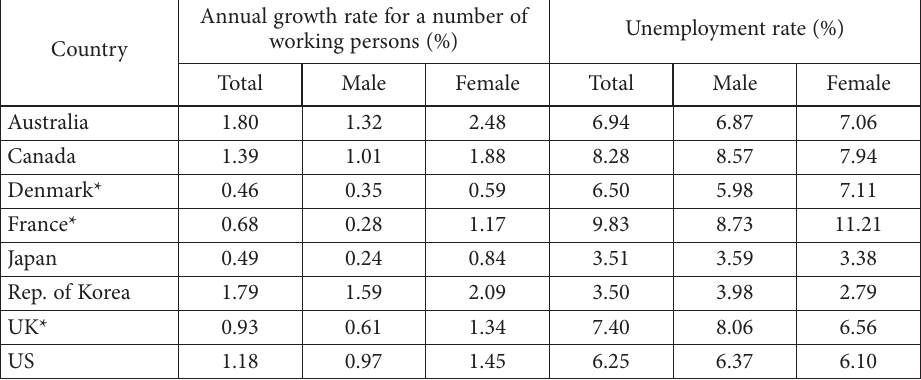
Table 1. Basic statistics of a number of working persons and the unemployment rate in selected coun- tries in the years 1981–2018 (source: own calculations based on the ILO data) Annual growth rate for a number of Unemployment rate (%) working persons (%) Country Total